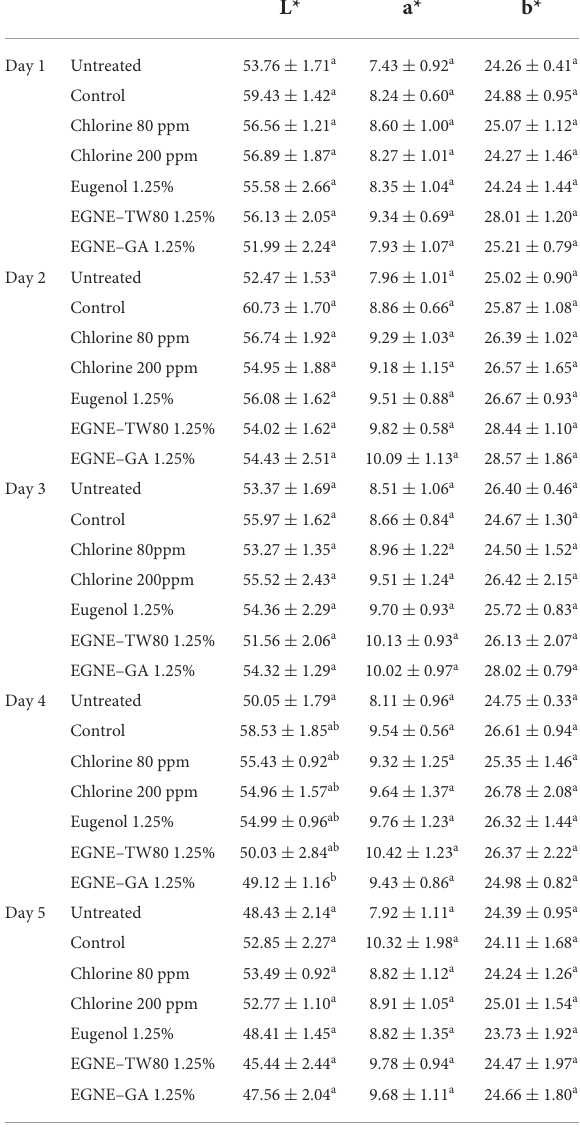
Values are expressed as mean ± SE. a,b superscripts represents significance difference between each treatment within each time point. L* indicates brightness, a* indicates the variationinred-green,b*indicatesthevariationofyellow-bluehue( n =